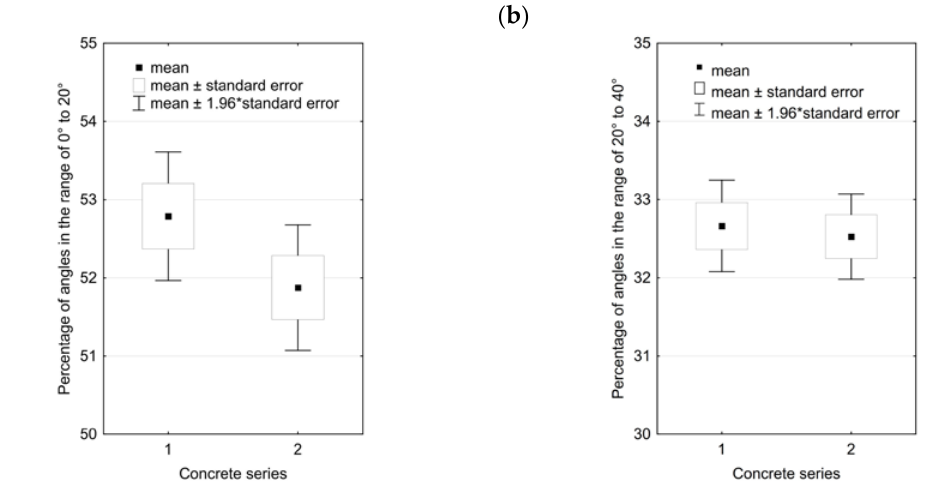
Figure 10. Graphic interpretation of the test for the equality of angles γ i occurrence mean frequency for specimen series 1 and 2 in the range of: a ) 0° to 20°, b ) 20° to 40°.